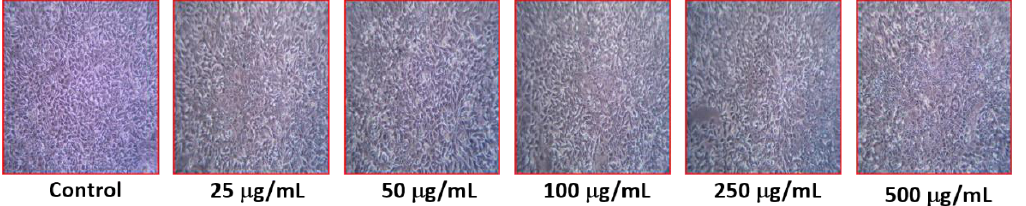
Figure 9. In vitro anti-cancer activity of Aw–AgNPs against HCC 712 human breast cancer cell lines at different concentrations (25–500 µg/mL).